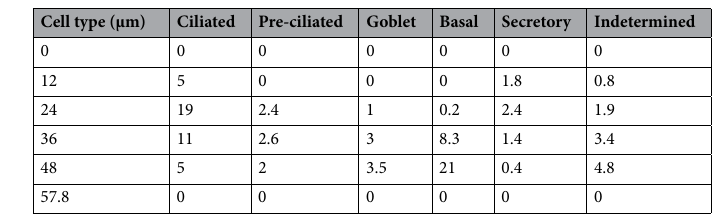
Table 2. Nucleus areal portions (%) for six cell types at varying depths from the surface of the bronchial epithelium 54 .